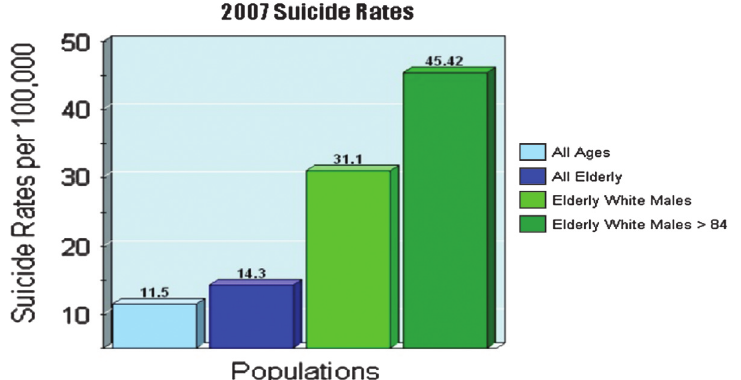
Figure 1. Suicide rates per 100,000